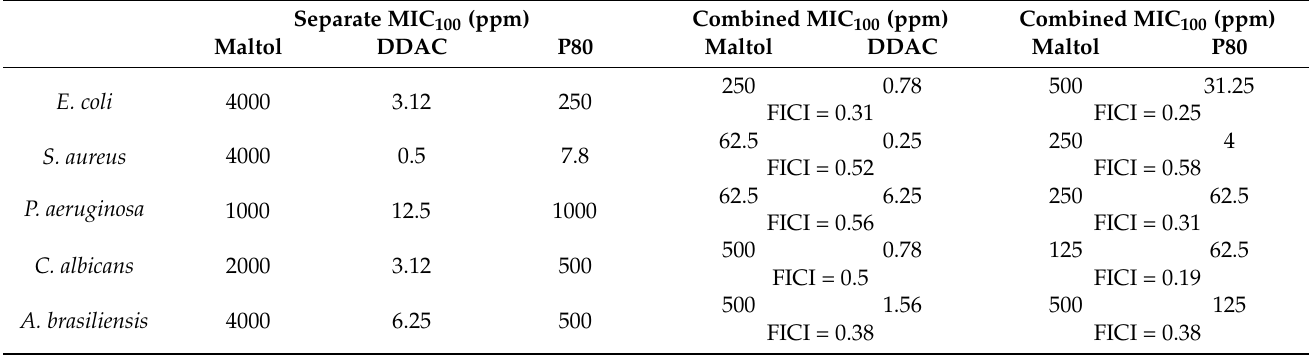
Figure 2. Checkerboard assay of maltol and DDAC against E. coli , S. aureus , P. aeruginosa , C. albicans, and A. brasiliensis . Growth measured after 24 h by O.D. 600 . On the X-axis, DDAC was diluted in a two-fold series dilution in concentra- tions range of 0.1–50 ppm. On the Y-axis, maltol was diluted in a two-fold series dilution in a concentration range of 62.5–4000 ppm. Yellow lines indicate MIC 100 values of individual compound alone. Red lines indicate the optimal concen- trations of the combined compounds. Final values are represented as the average relative growth in each well compared to the blank, based on three independent experiments. Table 1. MIC 100 values of the individual compounds maltol, DDAC, and P-80, and the combined blends of maltol with either cationic surfactant against E. coli, S. aureus, P. aeruginosa, C. albicans, and A. brasiliensis . MIC values were adopted from checkerboard assays (see Figures 2 and 3) for FICI